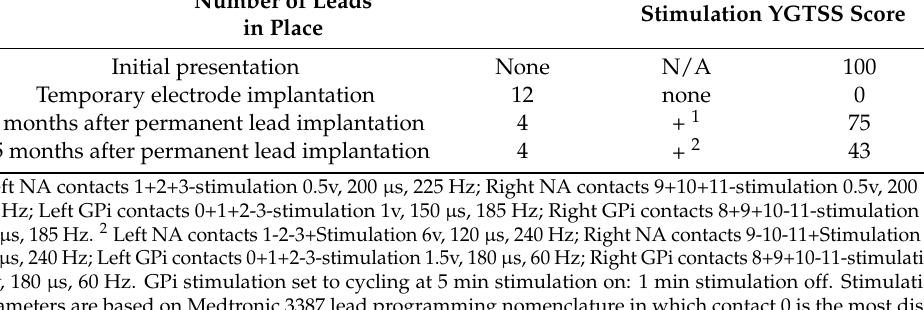
Table 3. Patient’s YGTSS scores over the course of treatment. Stimulation parameters at time of each assessment noted below. Number of Leads Stimulation YGTSS Score in Place Initial presentation None N/A 100 Temporary electrode implantation 12 none